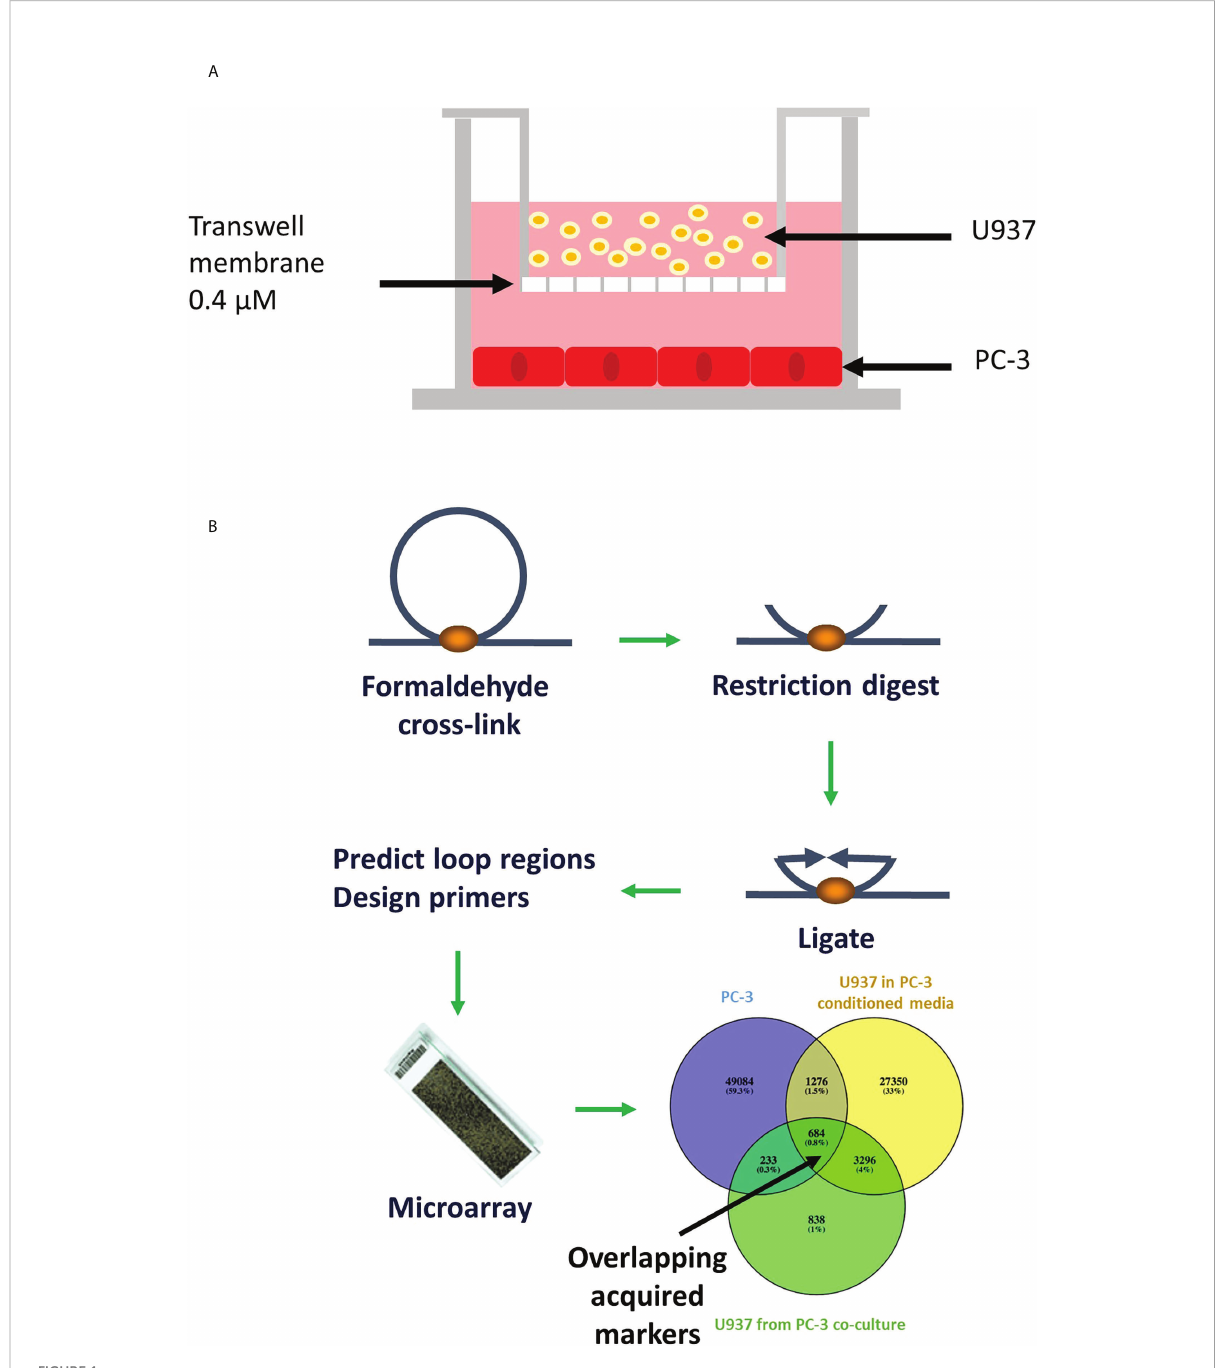
FIGURE 1 Schematic representation of the transwell model and chromosomal conformation assay. (A) PC-3 cells were cultured at the bottom chamber for 48 hours, then U937 cells were placed in the top chamber and incubated for 24 hours. (B) Chromosome conformation assay: DNA is crosslinked, digested, ligated and new sequences (in places where loops were) are predicted using relevance machine vector. Loops presence is detected using DNA microarray